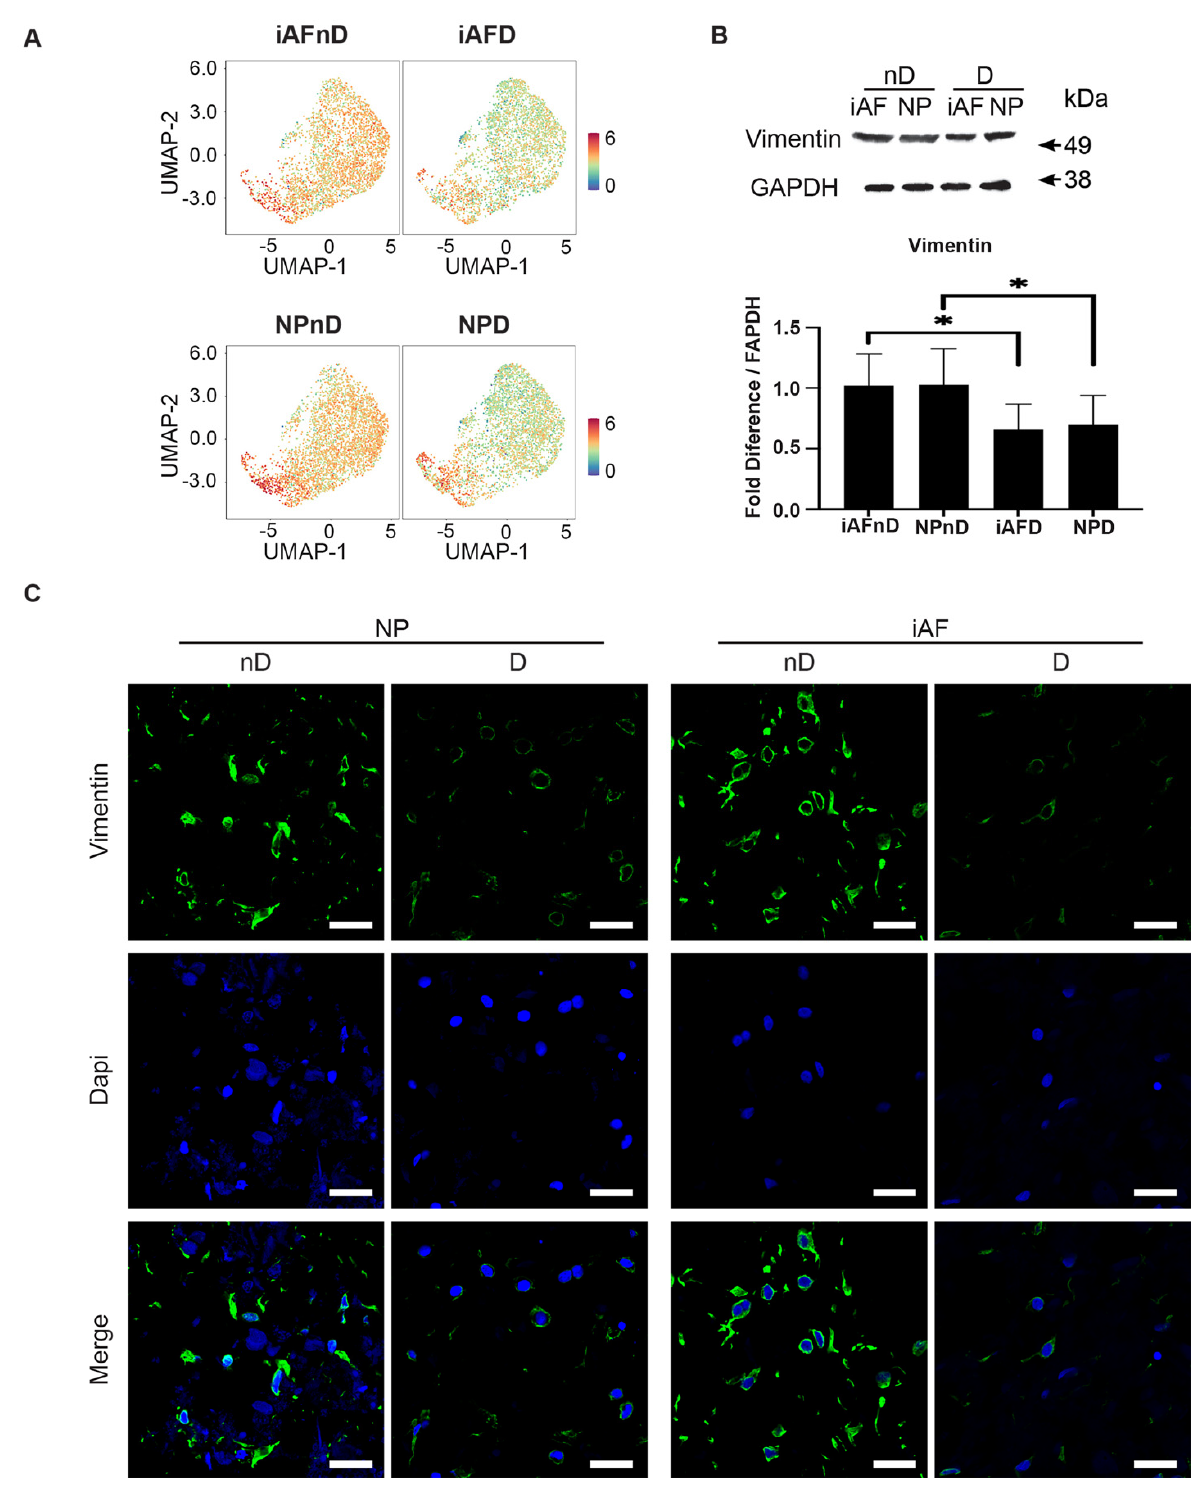
Figure 8. Validation of selected cell type and degeneration markers. ( A ) UMAP highlighting vimentin gene expression at the single-cell level in iAF and NP nD and D discs of the same individual. ( B ) Western Blot analysis of cell lysates from 5 additional individuals normalized to GAPDH (n = 5). ( C ) Immunohistochemistry staining of vimentin (in green), Dapi (in blue) and merged images of cells from 5 additional individuals (scale = 100 µm, n = 5 biological replicates). Graphs are presented as mean ± SEM. * p < 0.05